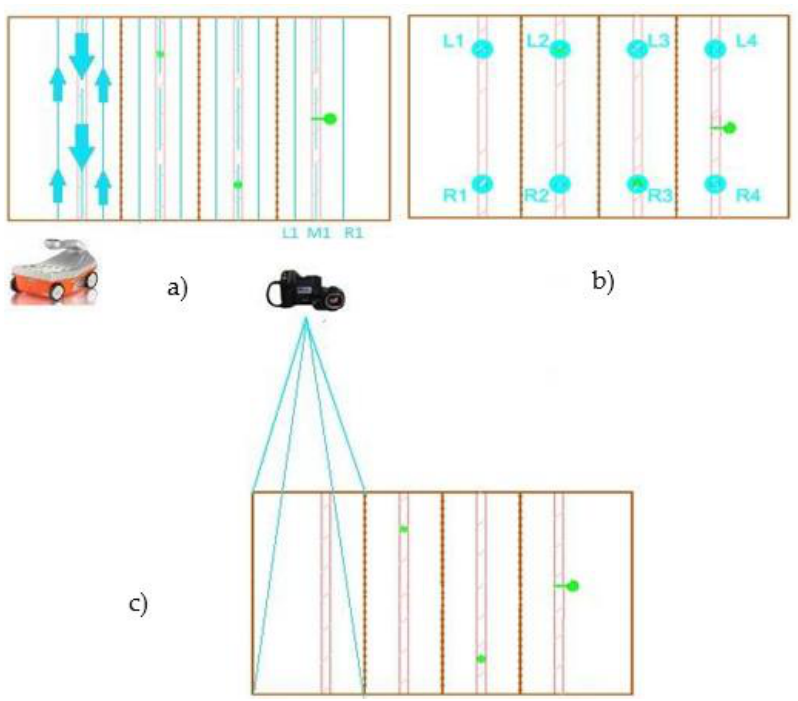
Figure 8. Survey plan for the experiments: ( a ) GPR; ( b ) spectrometer; and ( c ) IR camera. For processing of the IR images for leak detection, the region-growing algorithm (RGA) was used. RGA is a simple image segmentation method initiated from a seed